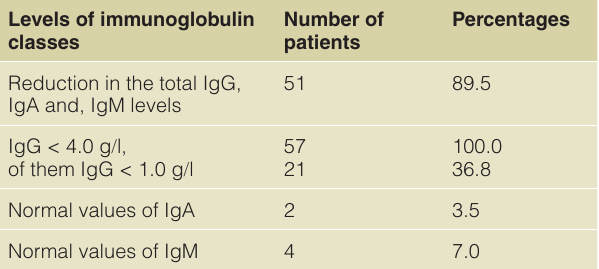
Table 3. Levels of immunoglobulin classes in patients with CVID before regular IVIG replacement therapy. Levels of immunoglobulin